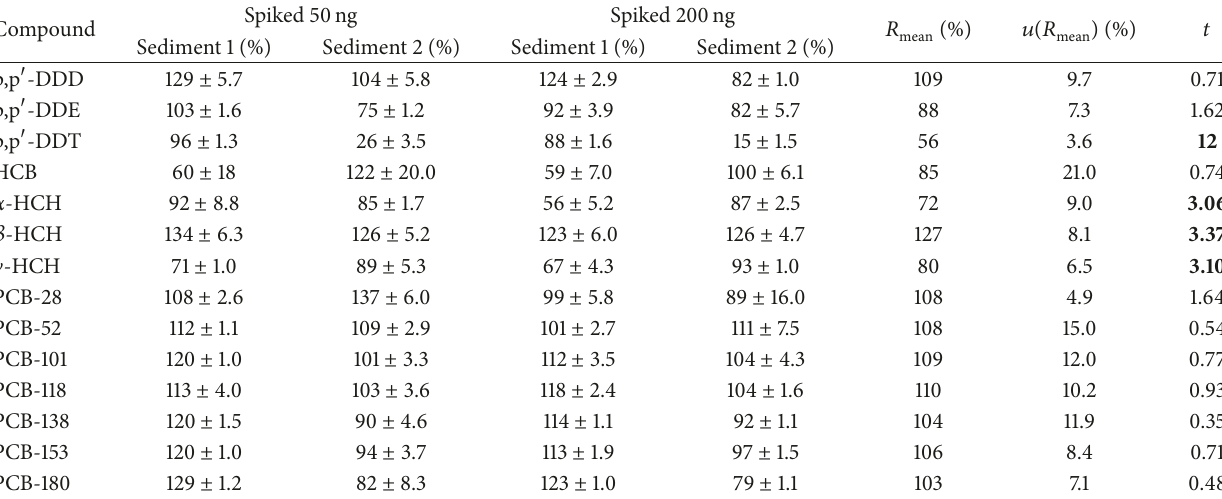
Table 2: Values of recovery and relative standard deviations (expressed in %) obtained from the analysis of two sediments spiked at two levels of concentration.